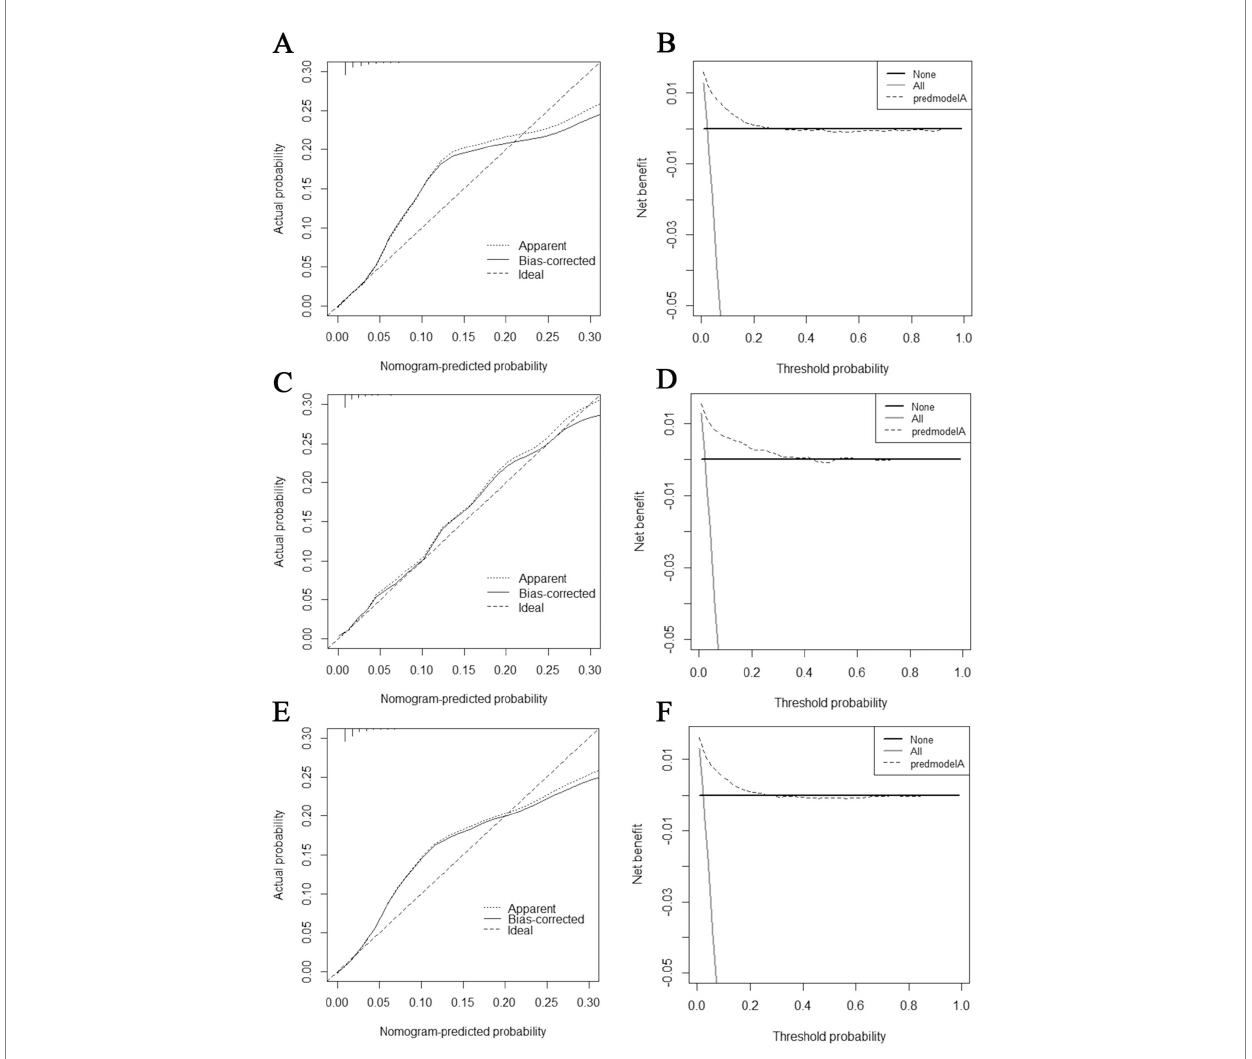
FIGURE 6 Calibration curves and decision curve analysis (DCA) curves for the training set (A,B) , calibration curves and DCA curves for the validation set (C,D) , and calibration curves and DCA curves for the extended validation set (E,F)